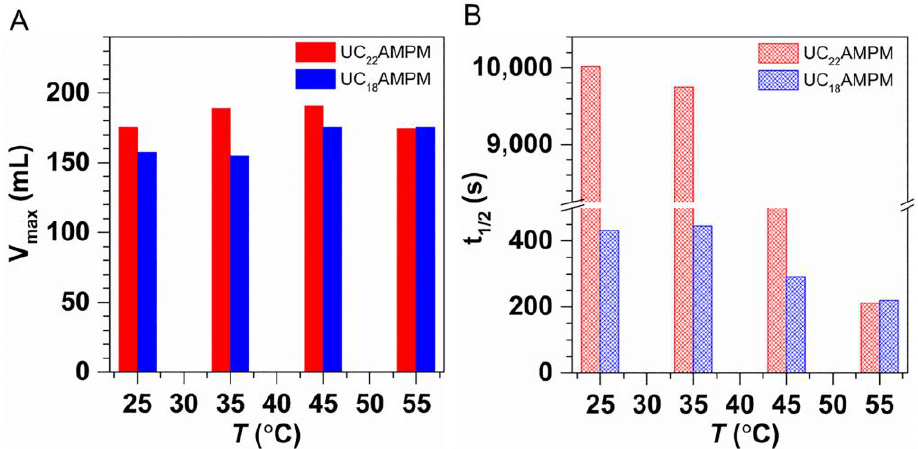
Figure 5. The ( A ) V max and ( B ) t 1/2 of 0.5% UC 22 AMPM dispersion and 0.5% UC 18 AMPM dispersion plotted as a function of temperature at 3 MPa in the presence of CO 2 , respectively.